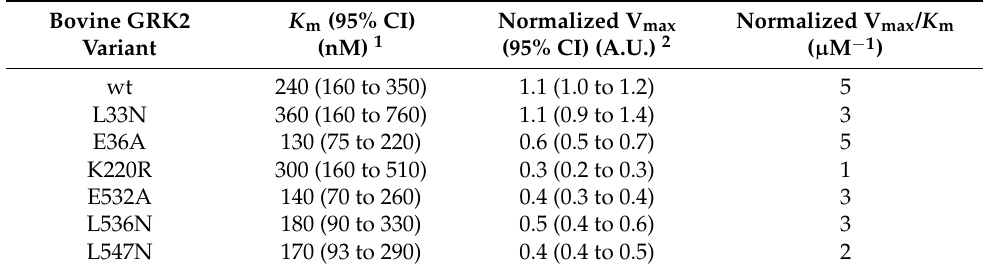
Figure 5. Michaelis–Menten analysis of the GRK2 variants varying the concentration of rhodopsin [rhodopsin]. Phosphory- lation of ROS by GRK2 mutants was assessed by SDS-PAGE (left, single representative experiment), and band intensities corresponding to the phosphorylated product from experiments performed in triplicate were plotted as a function of [ROS] (right). Error bars represent the SD. Table 3. Steady-state parameters for phosphorylation when [rhodopsin] is